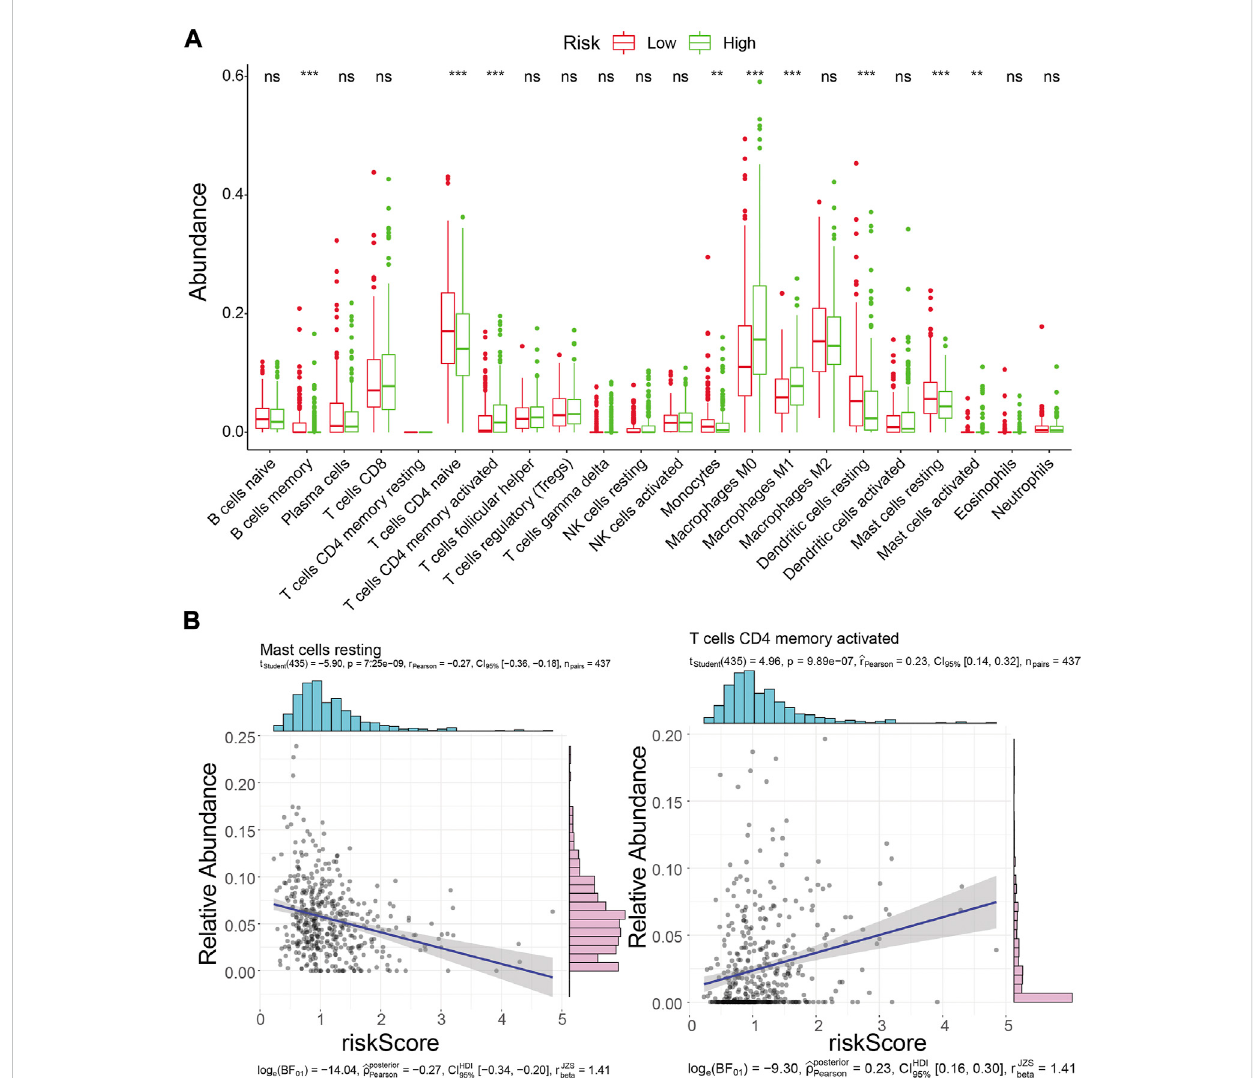
FIGURE 9 Immune landscape analysis. (A) Immune landscape of LUAD patients in the high- and low-risk groups. Differences in immune cell in fi ltration and immune-relatedpathwaysbetweenriskgroups.ns:notsigni fi cant;* p < 0.05;*** p < 0.01;*** p < 0.001;***** p < 0.0001. (B) Correlationanalysisofrisk scores with activated memory CD4 T Cells and mast cell resting abundance in the TCGA training